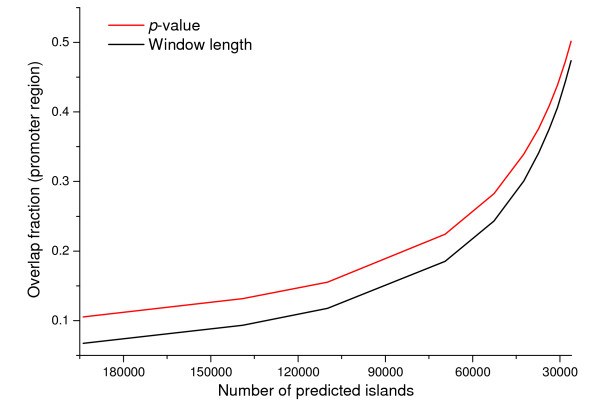
Variation of the overlap fraction of predicted islands with RefSeq promoter regions. The different sets of predicted islands have been obtained by varying the CpGcluster p-value and the SWA window length.